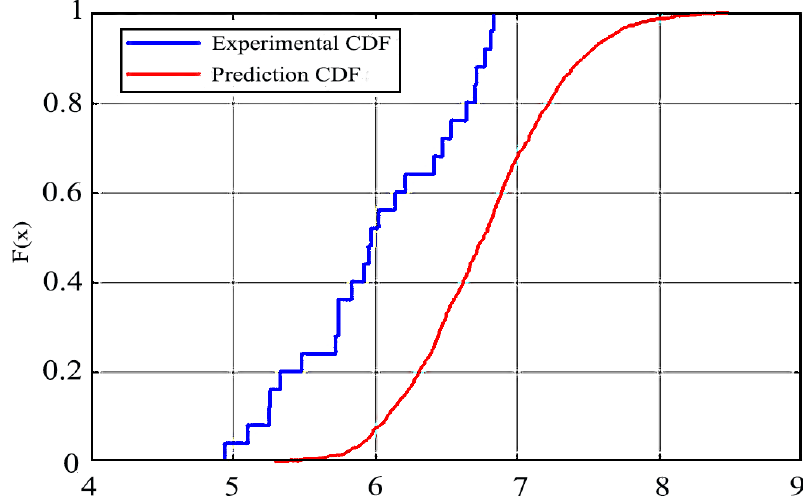
Figure 14. P-box of case I and its comparison with experimental results. Table 7. Stochastic characteristics of ultimate strength in case I.